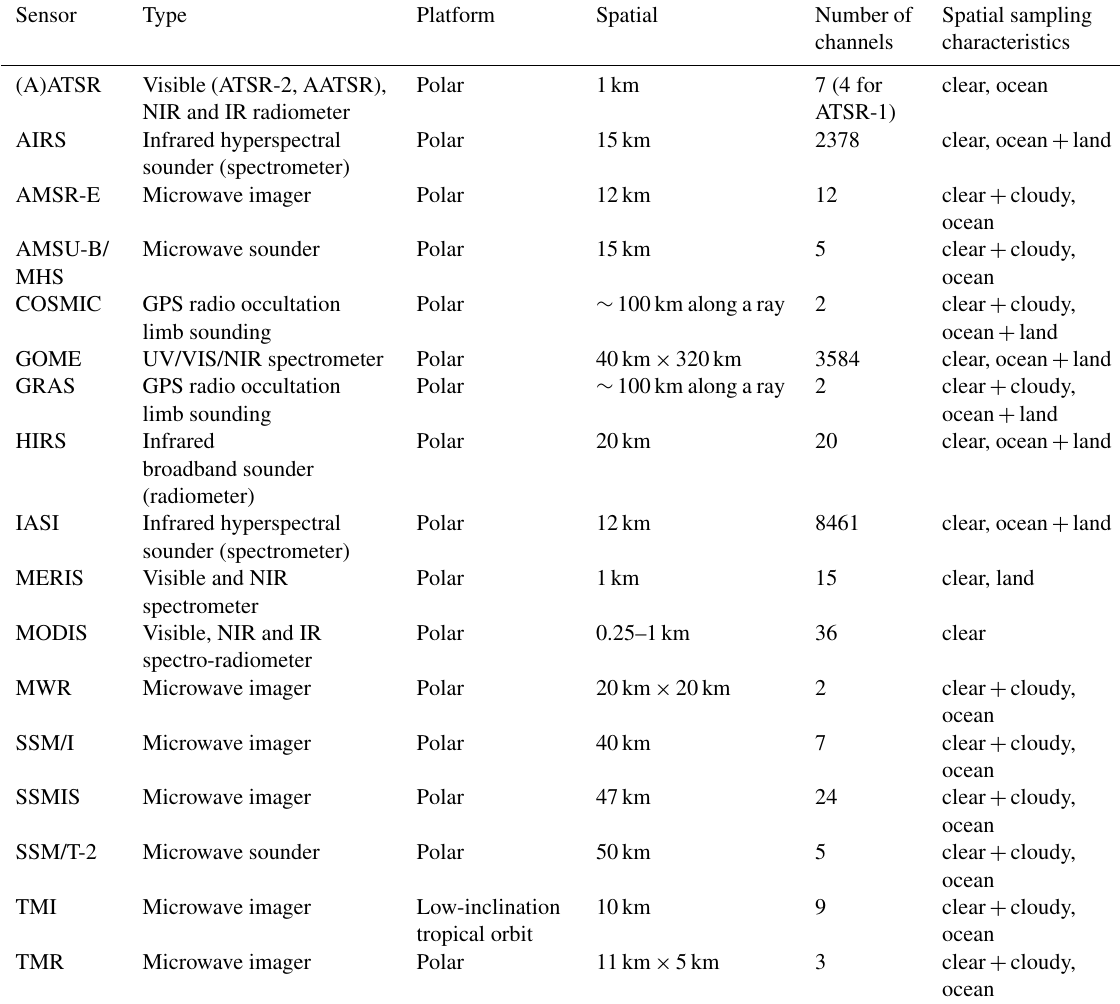
Table 1. Summary of the main satellite instruments used for water vapour climate data records. Spatial resolution is typically given at nadir. The last column provides information on the applicability of typical water vapour retrieval schemes under certain conditions and in certain